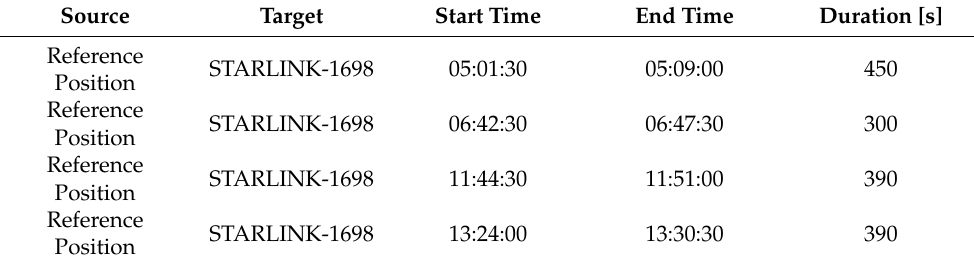
Table 4. Communication available time with STARLINK-1698 on 22 February